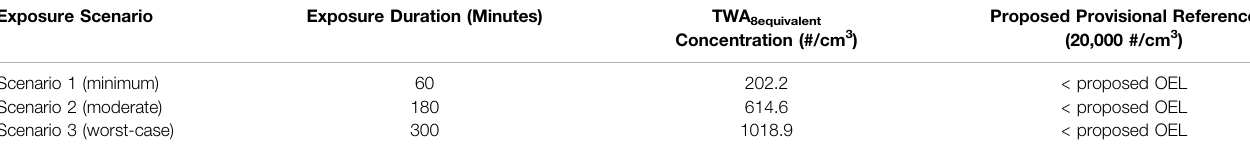
TABLE 4 | An 8-h equivalent exposure concentration compared against proposed provisional nano reference value for gold.